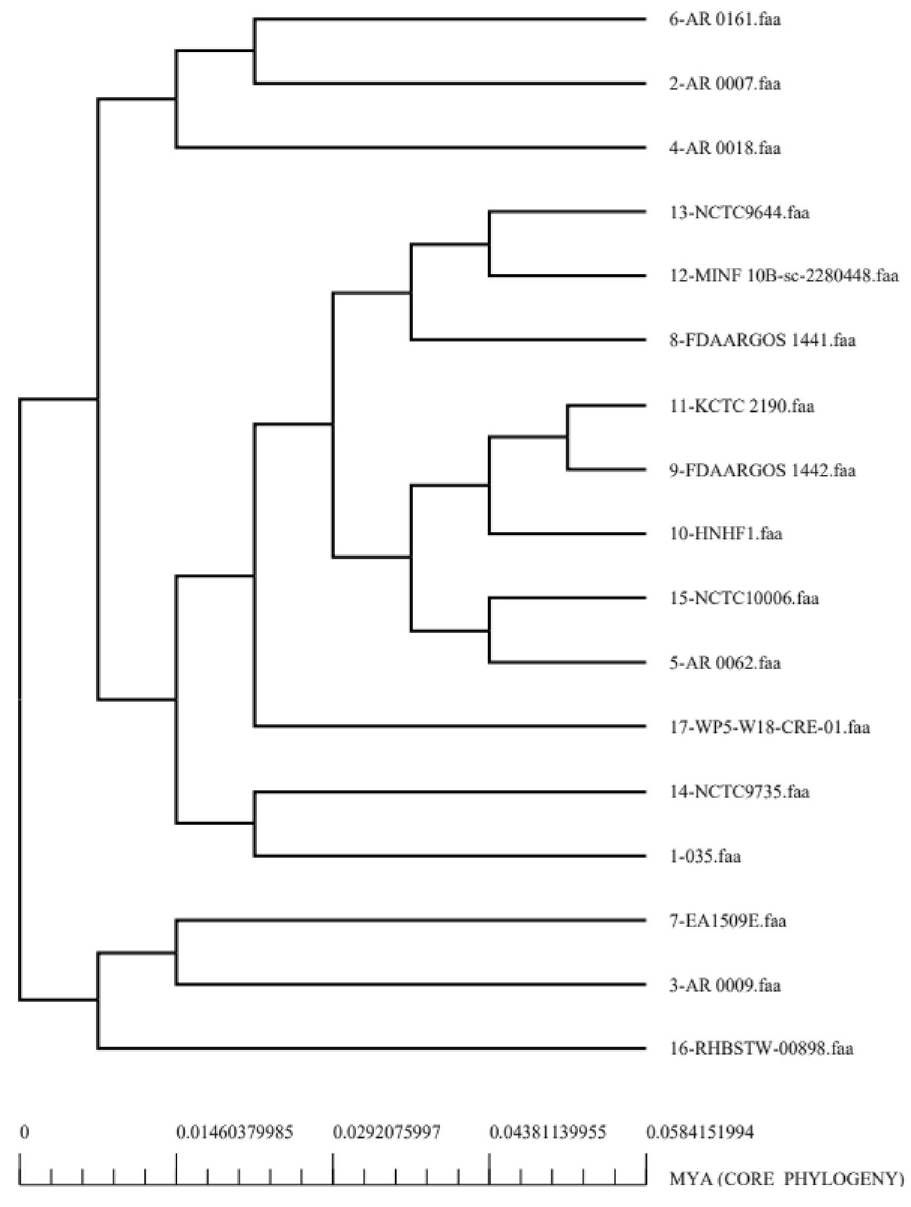
Figure 3. K. aerogenes strains phylogenetic